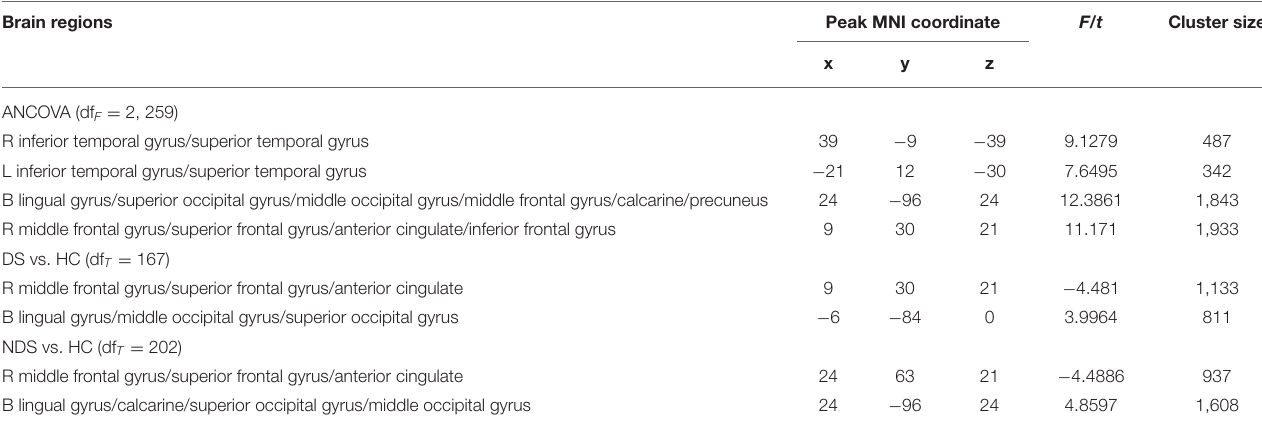
TABLE 4 | Altered regions of FC in the right NAcc network based on ROI analysis. Brain